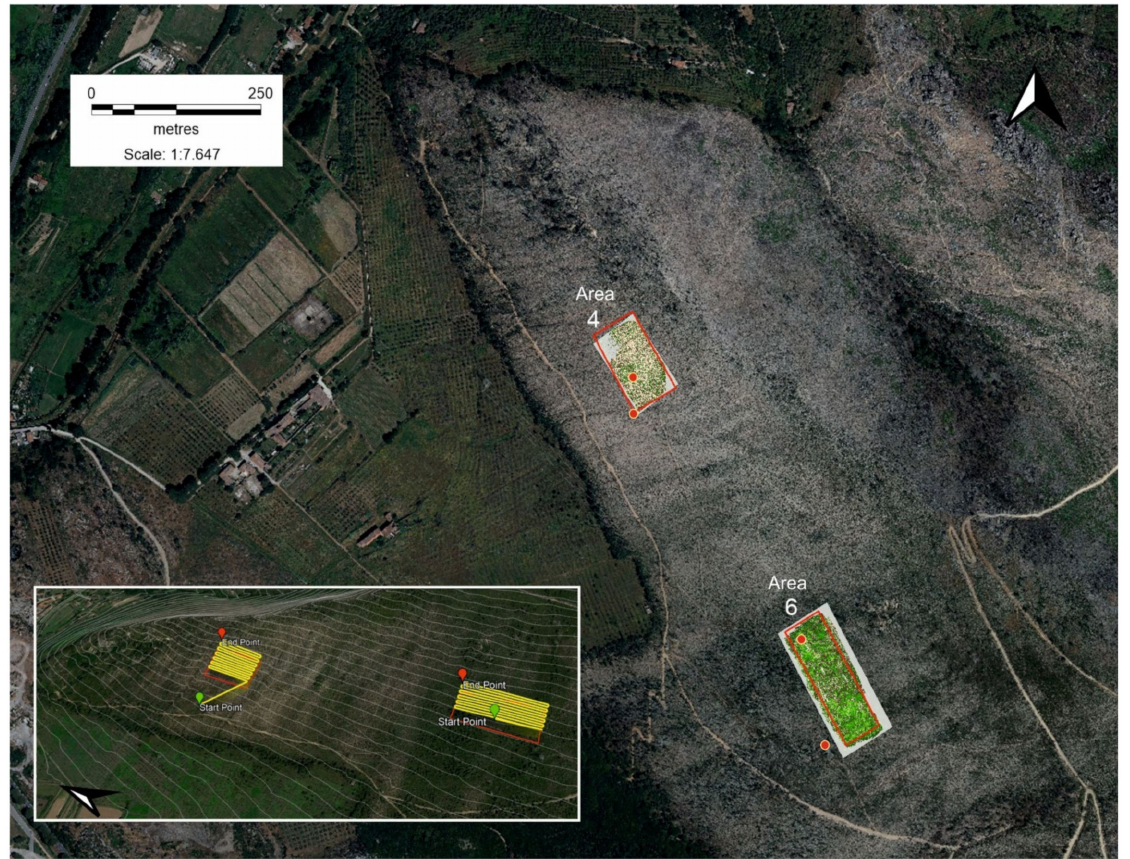
Figure 2. Identification of the two study areas (red rectangles) and 2018 relev é s (red dot); UAV—flight plane